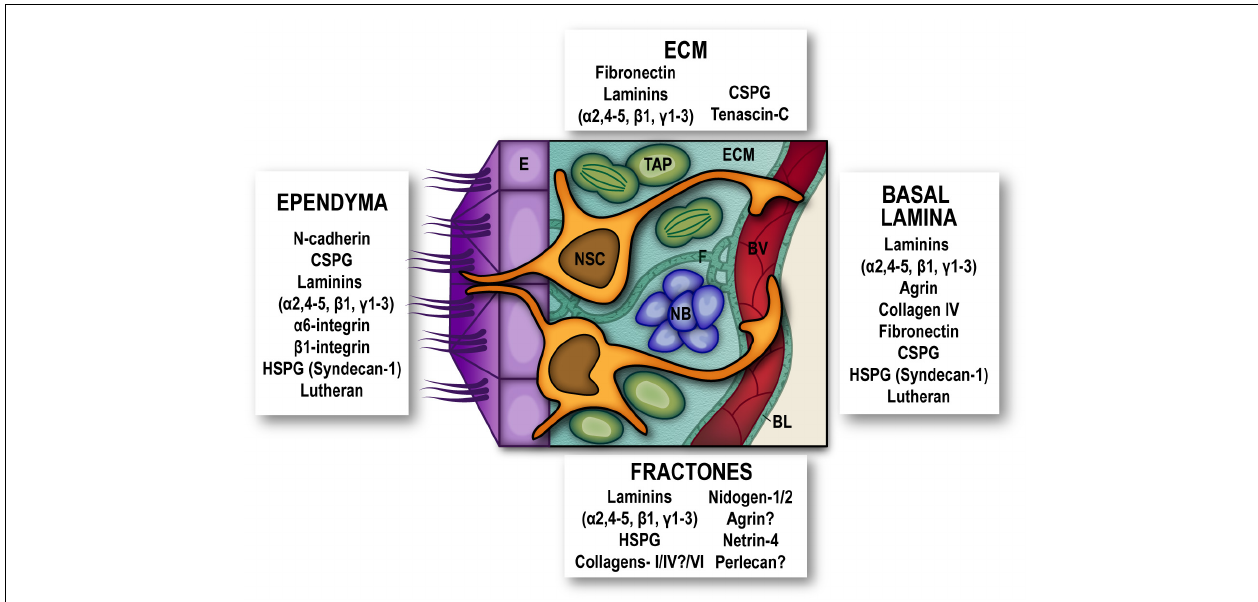
FIGURE 1 | Extracellular matrix and adhesion molecules are SEZ niche components. Schematic representation of the subependymal niche showing cellular populations (multiciliated ependymal cells –E, purple-, neural stem cells –NSC, orange-, transit amplifying progenitors –TAP, green-, neuroblasts –NB, blue- and blood vessels –BV, red-) and specific extracellular matrix proteins and adhesion molecules reported to be present subependymal zone extracellular matrix (ECM), in basal lamina (BL), fractones (F), and ependymal cells. Question marks are present where conflicting reports have been published. For the sake of clarity other niche elements such as microglia, non-neurogenic astrocytes and innervation have been omitted from the schematic. HSPG, heparan-sulfate proteoglycans; CSPG, chondroitin sulfate proteoglycans.